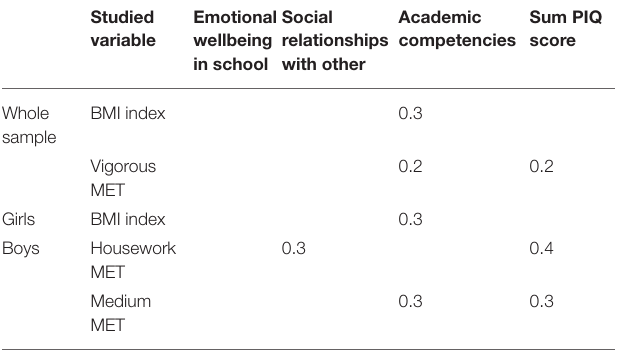
TABLE 4 | Correlation